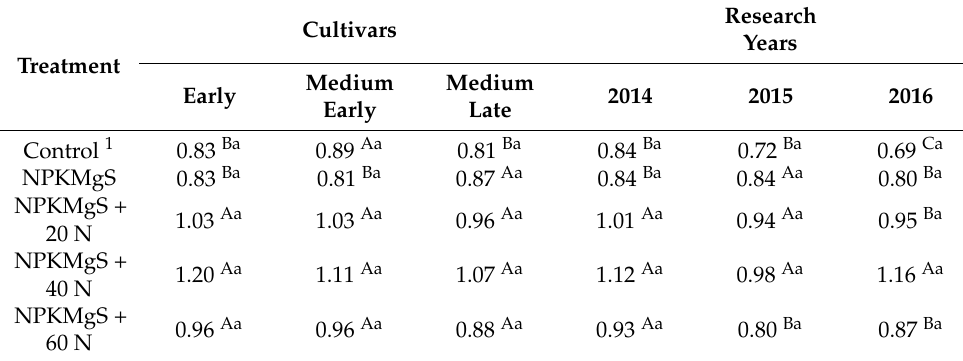
Table 3. Total organic carbon in soil (%).